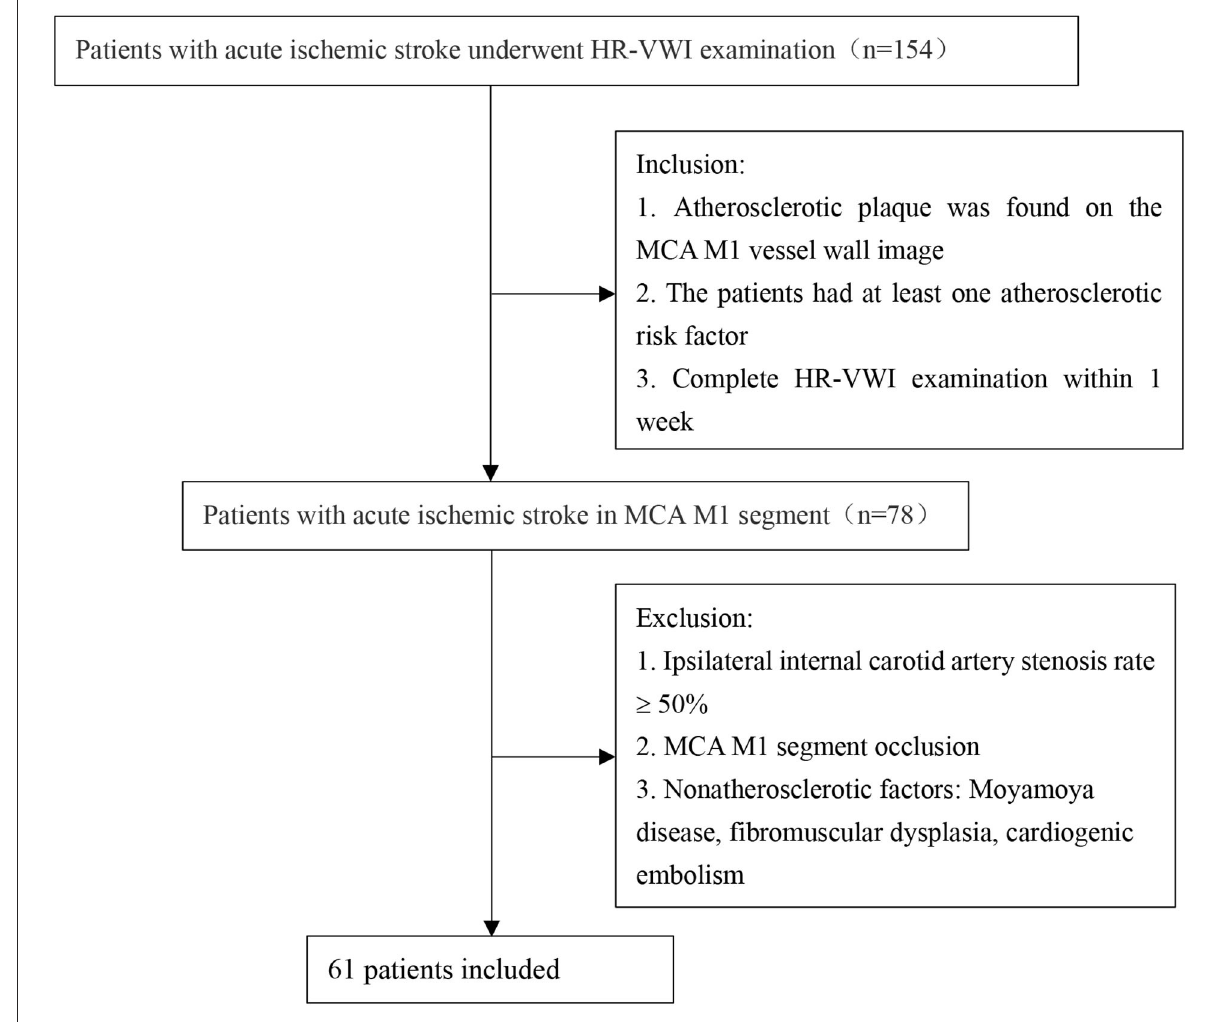
FIGURE1 A flowchart of patient recruitment. HR-VWI: high-resolution vessel wall